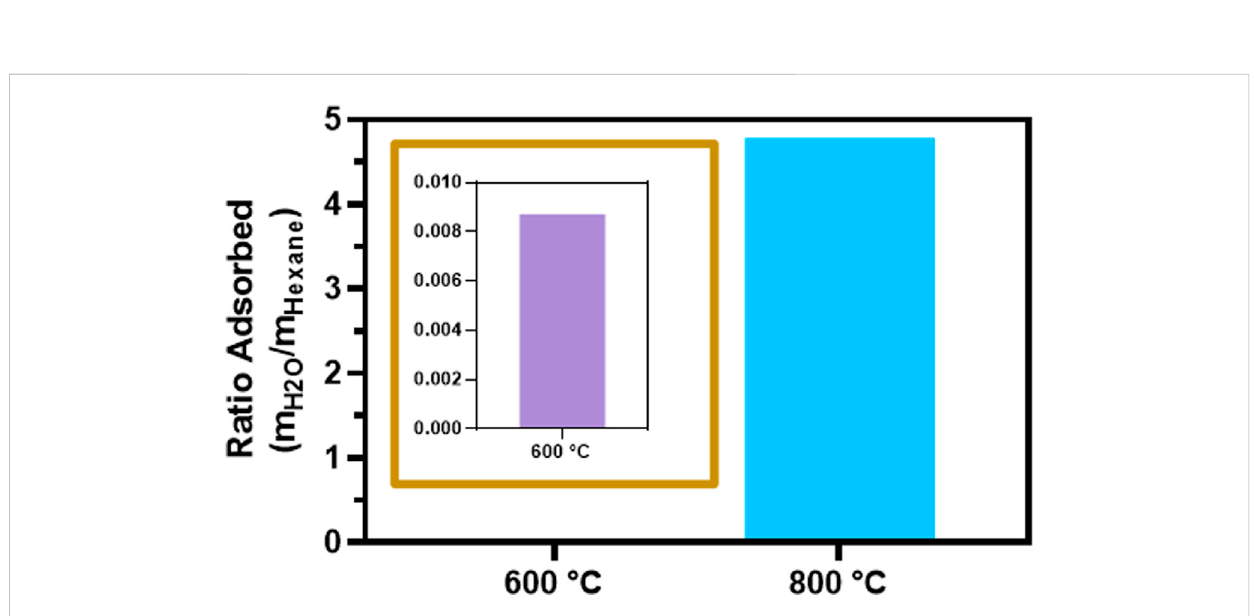
Water and hexane adsorption behaviour on SiOC pyrolyzed at different